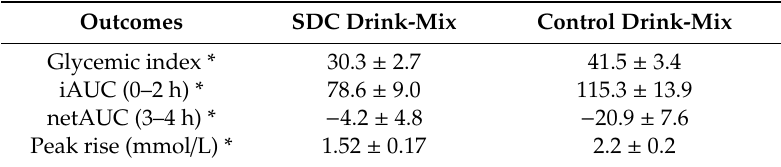
Table 4. Post-prandial glycemic response of